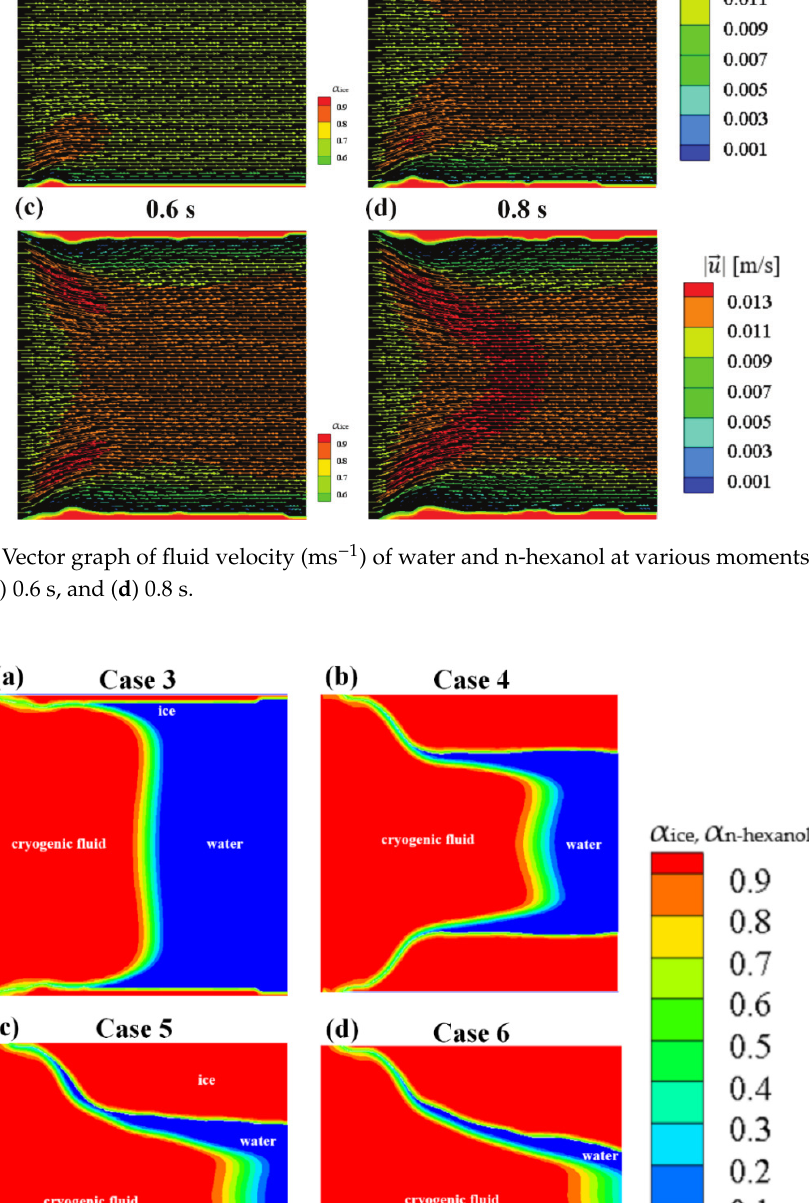
Figure 14. Vector graph of fluid velocity (ms − 1 ) of water and n-hexanol at t = 0.4 s under different initial ice phase distribution state ( a ) Case 3, ( b ) Case 4, ( c ) Case 5, and ( d ) Case 6.